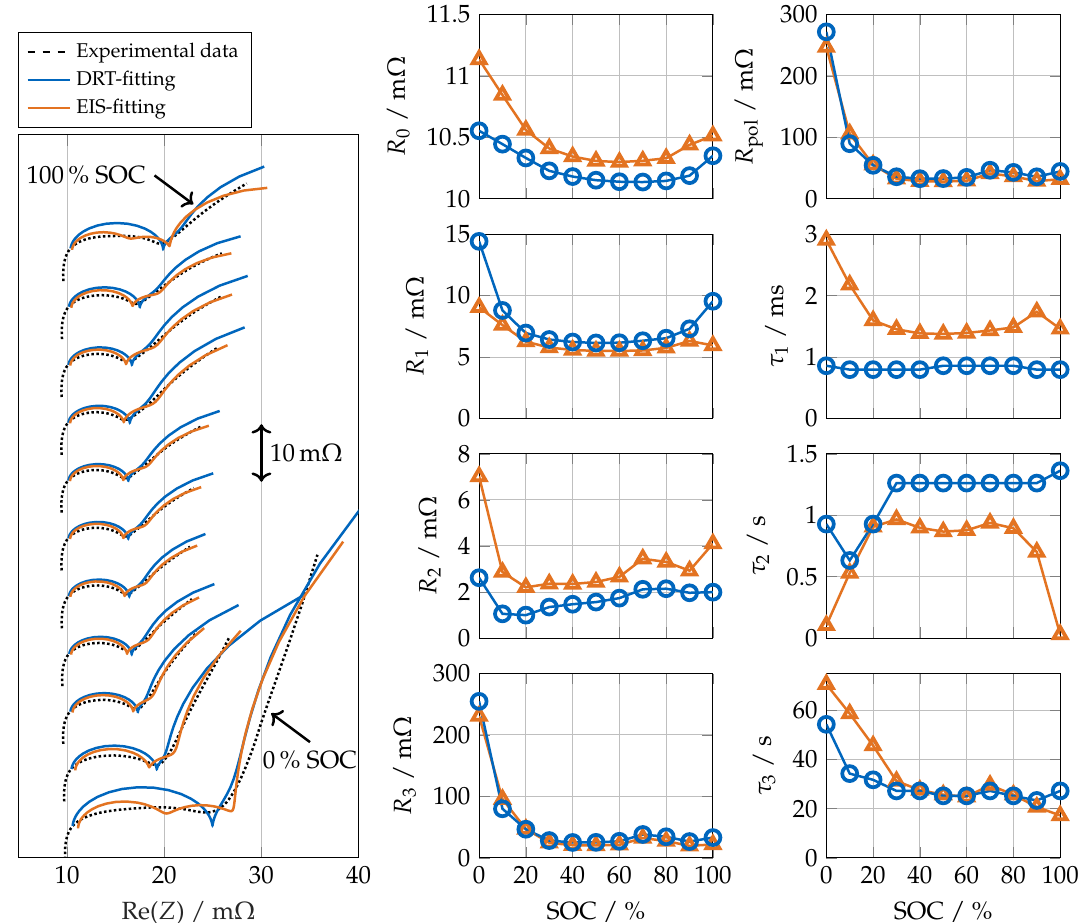
Figure 5. Left: Impedance spectra from EIS measurements and impedance spectra estimated by the proposed DRT-fitting and benchmark EIS-fitting for different SOC at 20°C. Impedance spectra are shifted in the y-direction according to the SOC for the sake of better visibility. Right: Resulting ECM parameters over SOC for DRT-fitting and